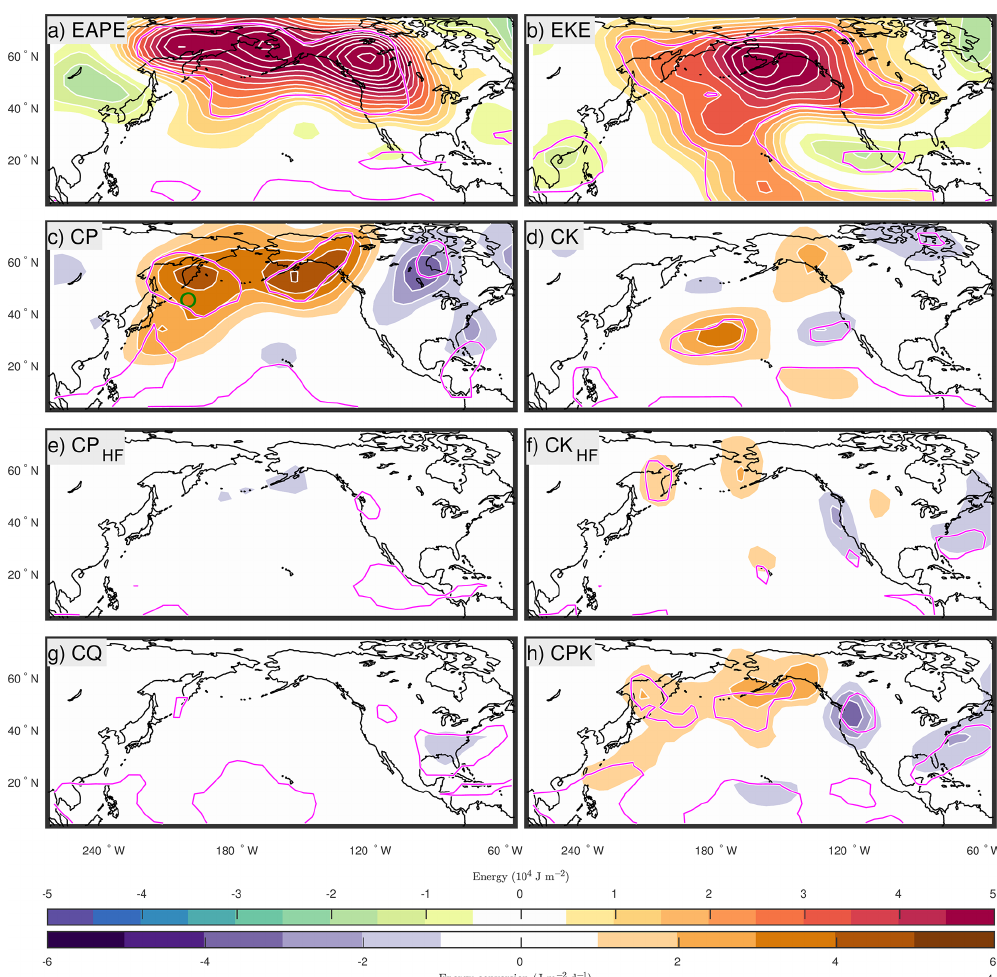
Figure 3. (a) Eddy available potential energy (EAPE), (b) eddy kinetic energy (EKE) of subseasonal eddies and energy sources/sinks (c–h) , all regressed onto the SVD1 SST index. (c) CP and (d) CK are the baroclinic and barotropic energy conversions, respectively. (e) CP HF and (f) CK HF represent the baroclinic and barotropic high-frequency eddy feedbacks. (g) CQ is the diabatic feedback. (h) CPK represents transfers from EAPE to EKE. Correlations that are statistically significant at the α FDR = 0 . 1 significance level are contoured in magenta. The green circle in panel (c) indicates the reference location for Fig.